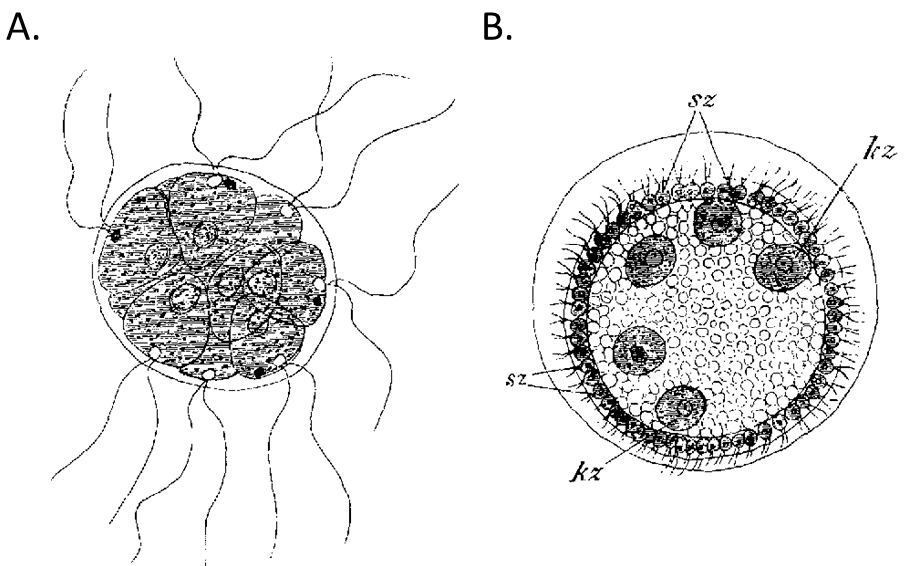
Figure 1. The appearance of germline and somatic cells in the evolution of metazoans. Two Volvocinian genera that were used by Weismann to illustrate the difference between ( A ) a homoplastid organism ( P. morum ) consisting of a single cell type and the evolution of ( B ) a heteroplastid ( V. minor ), which has evolved to consist of two primary cell types: the germline cells (Kz) that form the internal embryos and somatic cells (Sz), which are subject to death upon which the developing embryos are released.